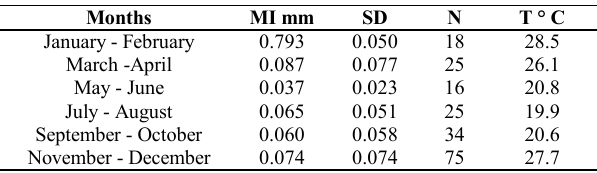
Table 1 . Bimonthly average marginal increment (MI) in scales of L. acutidens. SD = standard deviation, N = number of individu- als sampled, T°C = average water temperature during